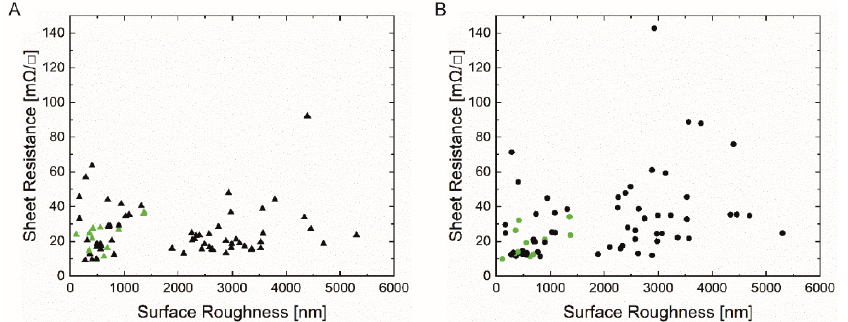
Figure 4. Sheet Resistance as function of Surface Roughness of 5 ‘Orgacon SI-P2000 ′ ( ▲ , A ) and ‘Loctite ECI 1011 ′ square prints ( ● , B ). Green symbols indicate the 13 paper samples that were selected for further investigation.